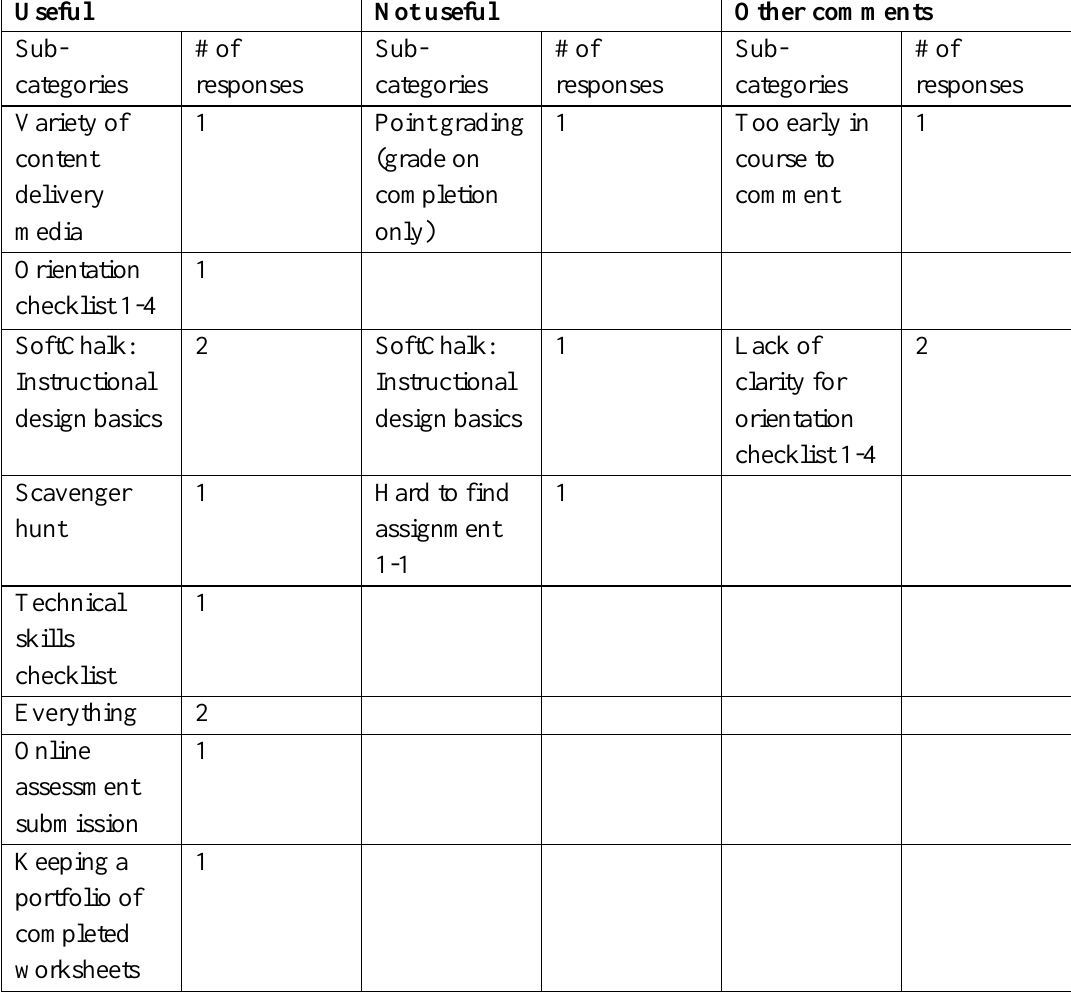
Table 5 Module One: Did any assignments stand out for you as being particularly useful, not useful? Do you have any comments you want to add about the assignments? (Each response was categorized into fields, and the number of responses indicates the total number of times that a particular topic was mentioned in all survey responses)